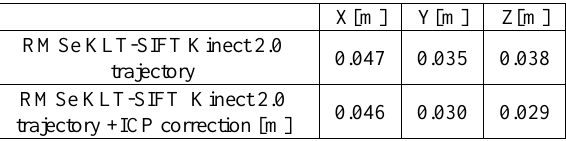
Table 2 - RMSe of GPR position between the Kinect